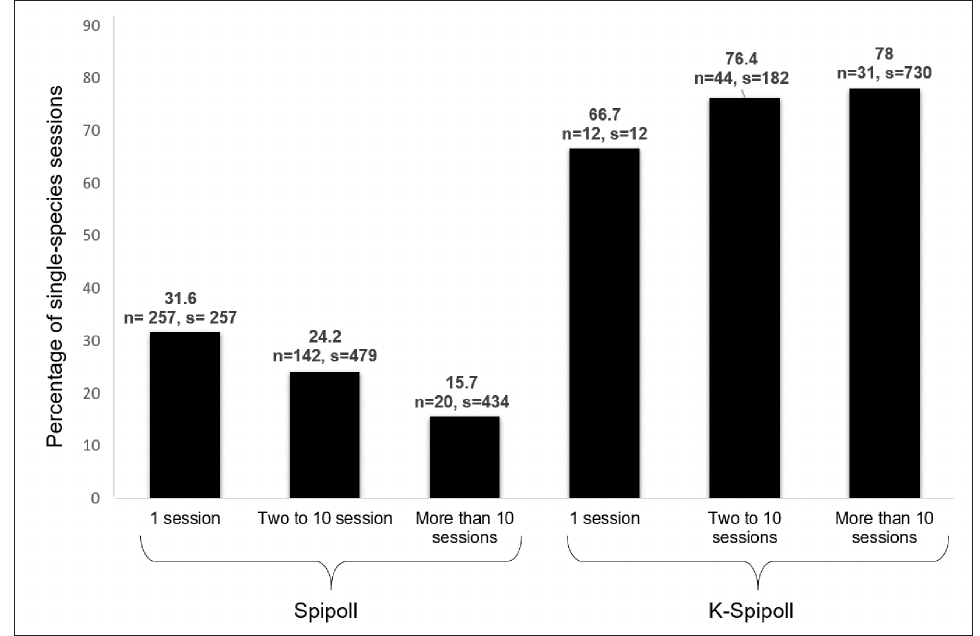
Figure 1: Percentage of single-species sessions according to the participant’s volume of sessions (where n represents the number of participants and s the sum of sessions).